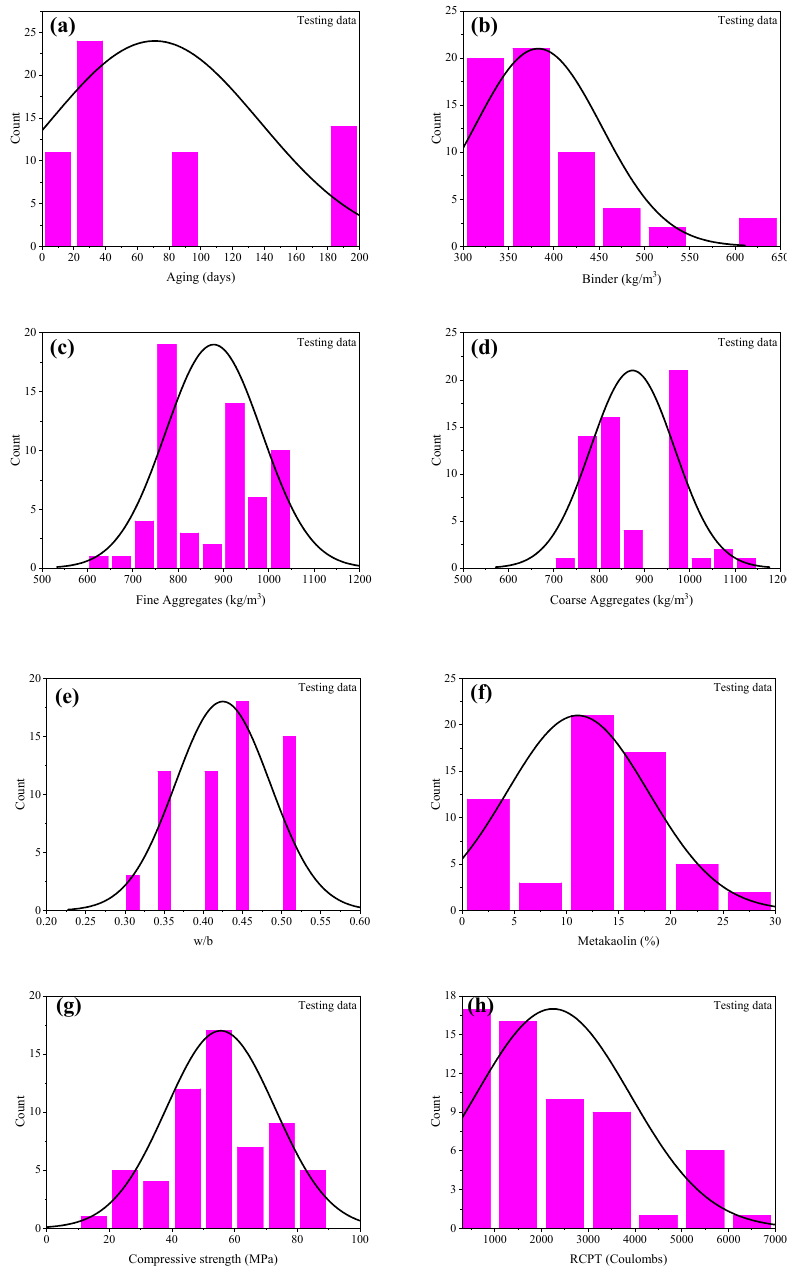
Figure 1. Frequency histograms of input and output variables; Training dataset (dark blue histograms) and test data (pink colored histograms) ( a – h ) for age, binder, fine aggregate, coarse aggregate, w/b ratio, metakaolin, compression strength and RCPT, respectively.